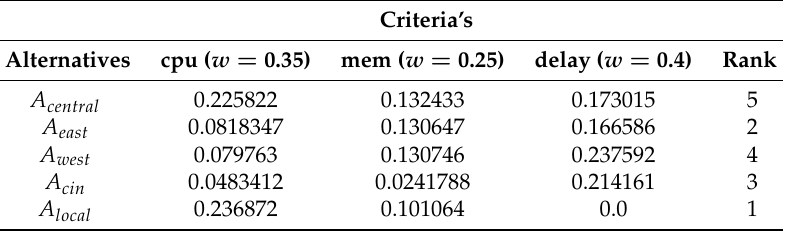
Table 2. Normalized-weighted decision matrix (NWDM) with